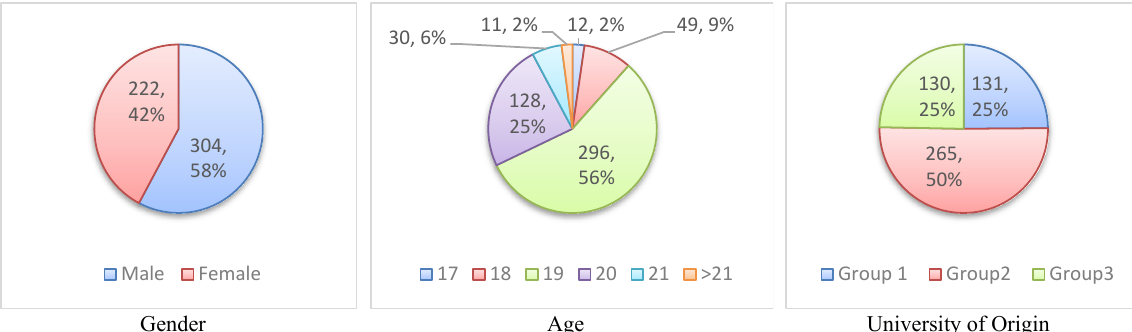
Fig. 2. Personal characteristics of the